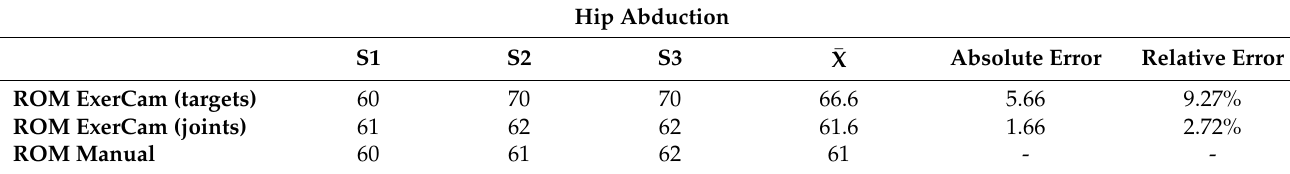
Table 5. Results of the measurements in the hip abduction